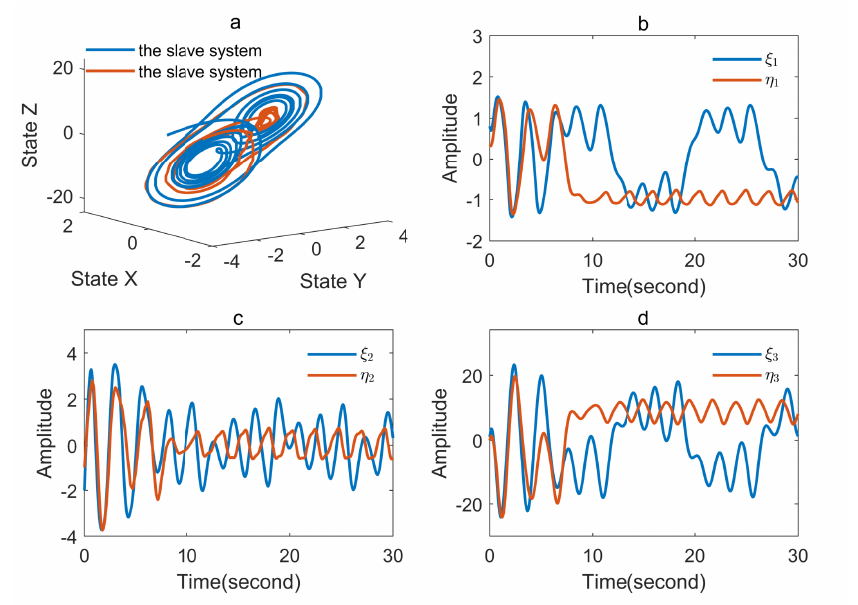
Figure 1. Master system with ξξξ = [ 0.8, − 2,1 ] T and slave system with ηηη = [ 0.35, − 1,0 ] T : ( a ) Dynamical behavior of the master system (63) and the uncontrolled slave system (64). ( b ) System states ξ 1 and η 1 . ( c ) System states ξ 2 and η 2 . ( d ) System states ξ 3 and η 3 . The controller parameters are designed as c 1 = 8, c 2 = 12, c 3 = 16, µ = 2, τ ( 0 ) = 0.4, q = 0.1, ¯ q = 0.05, k τ = 0.3, ω 1 = ω 2 = 5, β 1 = β 2 = 0.5; the adaptive update parameters are chosen as γ 21 = γ 31 = 1.2, γ 22 = γ 32 = 2, ρ 2 = ρ 3 = 0.5; the disturbance observer SSS 2 ( ηηη ) contains 225 a 22 = a 32 = 1.5; and the other initial values are chosen as zero. WWW T 2